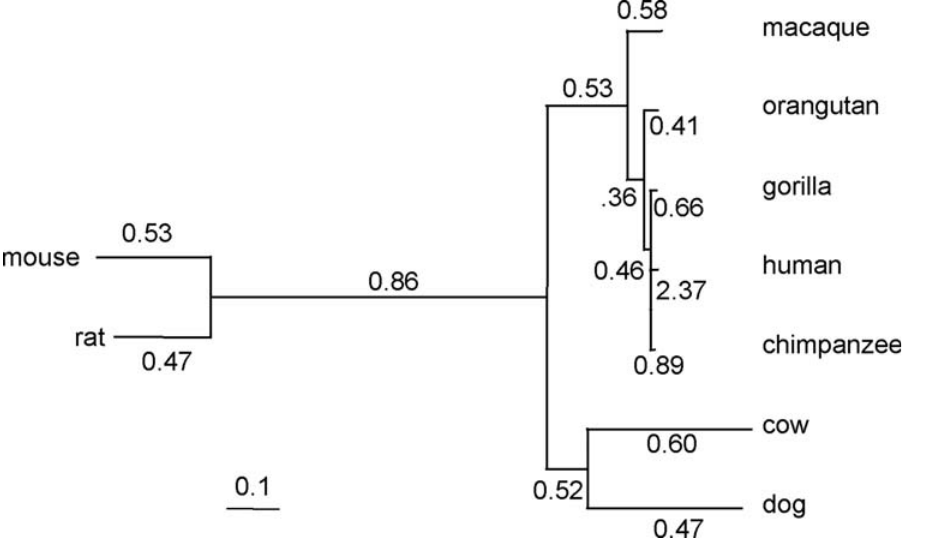
Figure 4. The phylogeny for nine mammalian species. The branch lengths, in the expected number of nucleotide substitutions per codon, are estimated under the free-ratios model [18] from analysis of the BRCA1 genes, while the estimated v ratios for branches are shown along the branches.